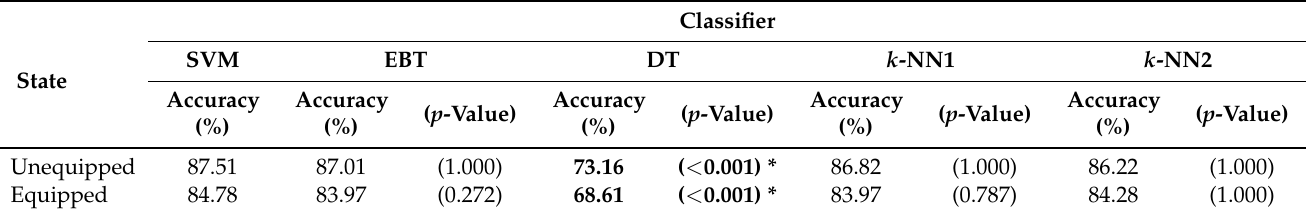
Figure 2. Box plot presenting the classifier accuracy of all 7 activities, for each equipment state, as calculated by each machine learning algorithm for all sensor locations (17 sensor nodes). Note the vertical axis does not start from zero to aid readability. Table 7. Percentage of correctly classified instances of all 7 activities for each equipment state as calculated by each machine learning algorithm. Results present the mean classifier accuracy of all sensor locations (17 sensor nodes), classification produced through 10-fold 10-iteration cross- validation. * denotes significant difference in percentage